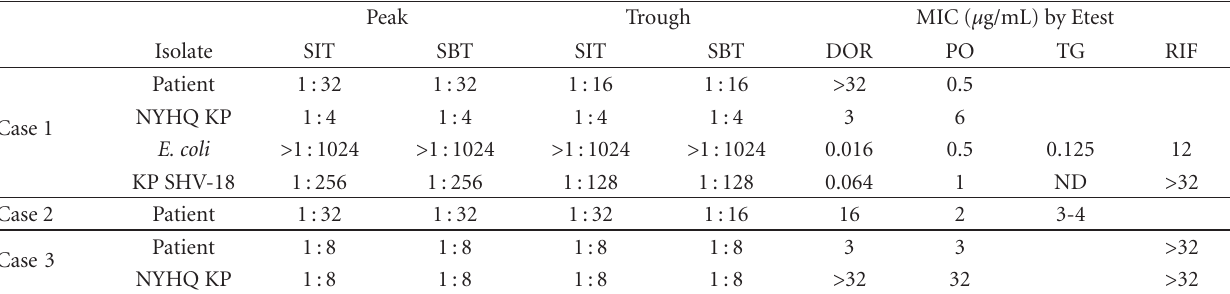
Table 1: Peak and trough serum inhibitory/bactericidal